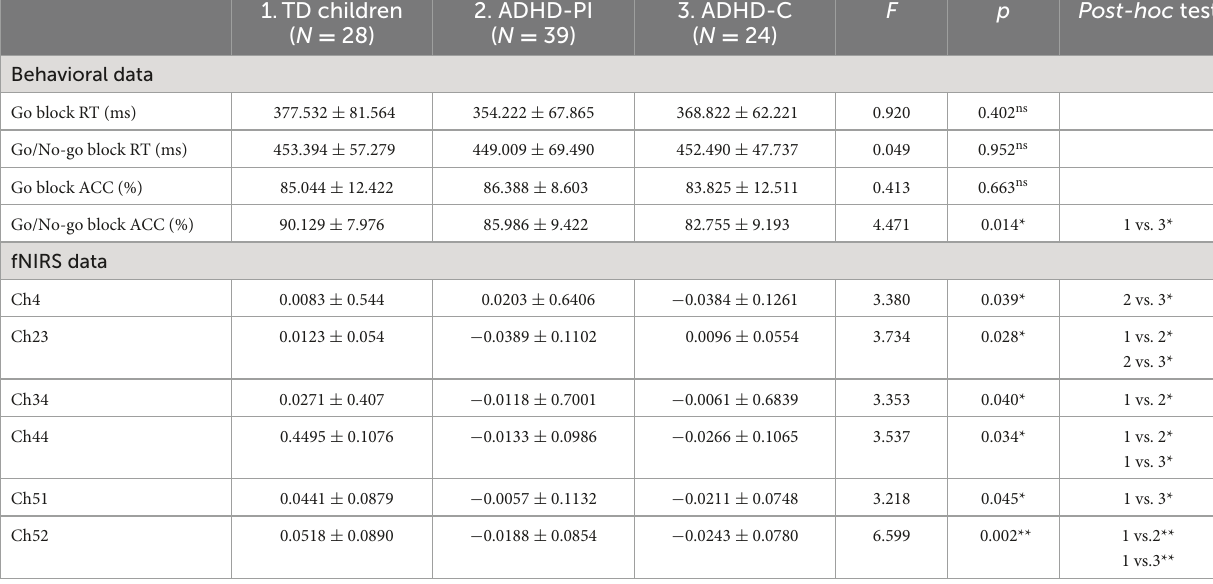
TABLE 3 Behavioral data and fNIRS data associated with response inhibition during go/no-go